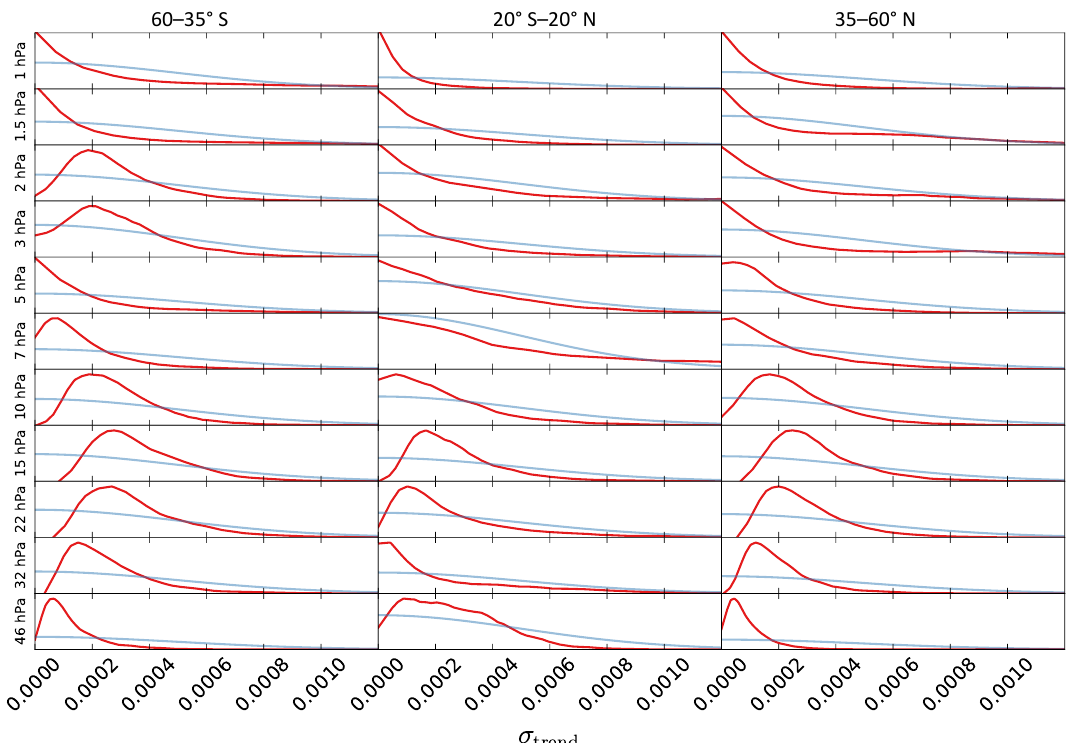
Figure A4. Recovered posteriors on σ trend (red) and the chosen half-Gaussian prior with dispersion 0 . 0005 (blue) from the DLM analysis performed in Sect.